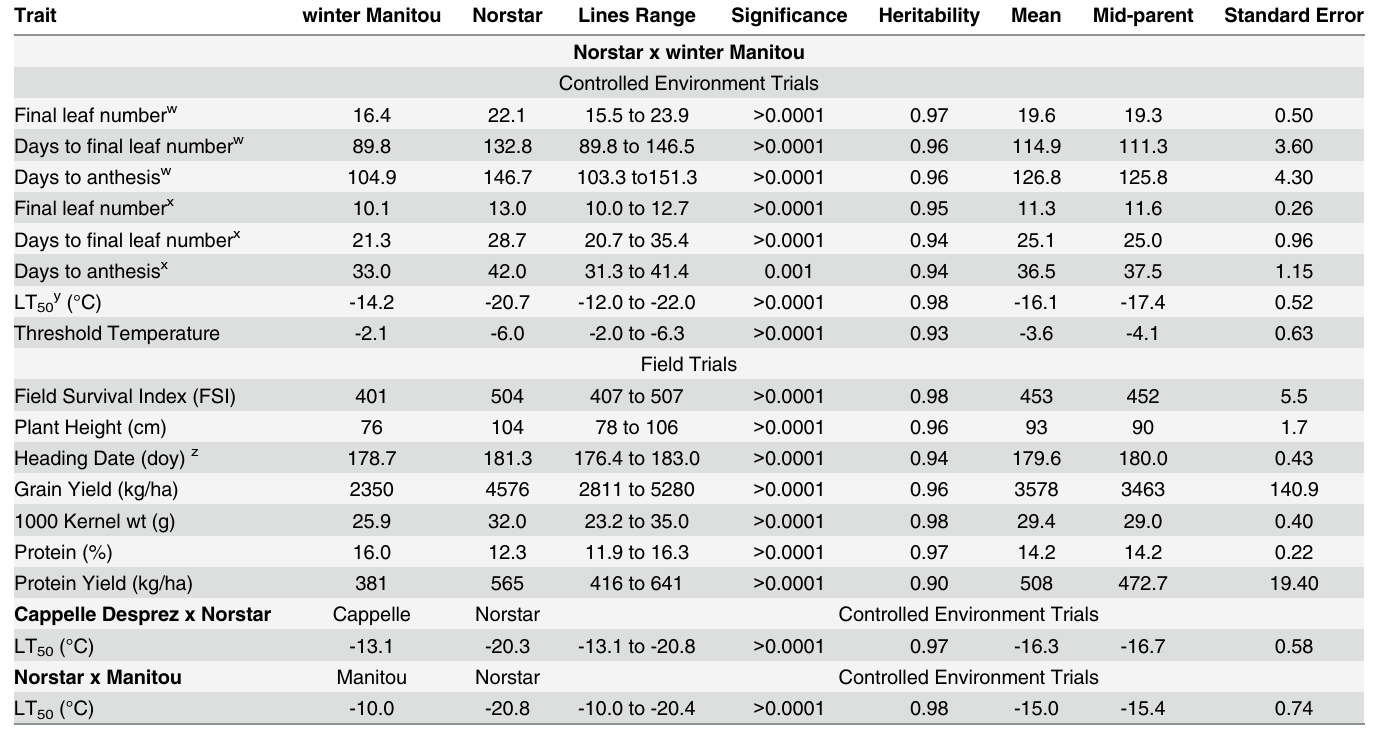
Table 1. Phenotypic data for mapping